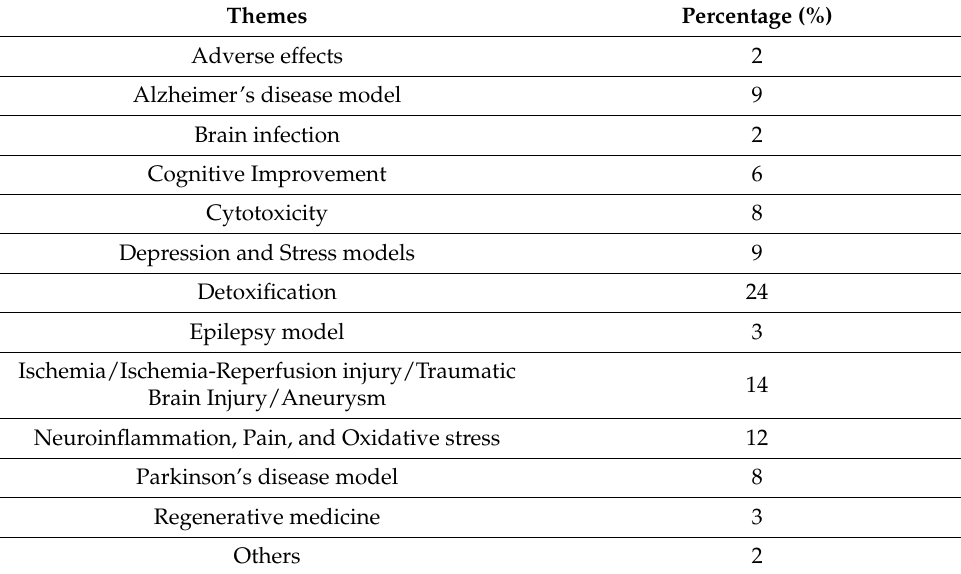
Table 1. The key themes of the included studies.